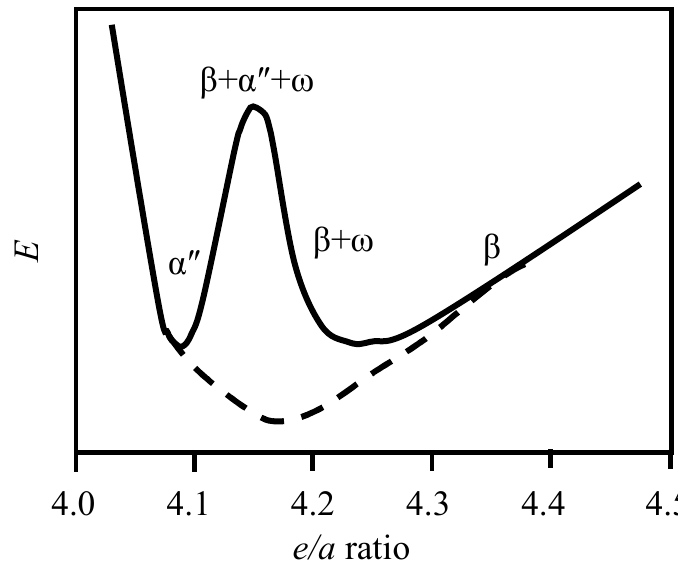
Figure 6. Elastic modulus vs. e/a ratio value of the TiZrTa alloys.